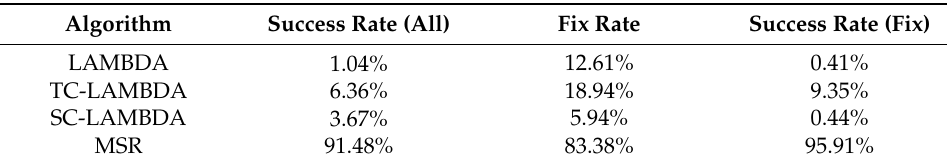
Table 4. Results of different algorithms under multipath environment.